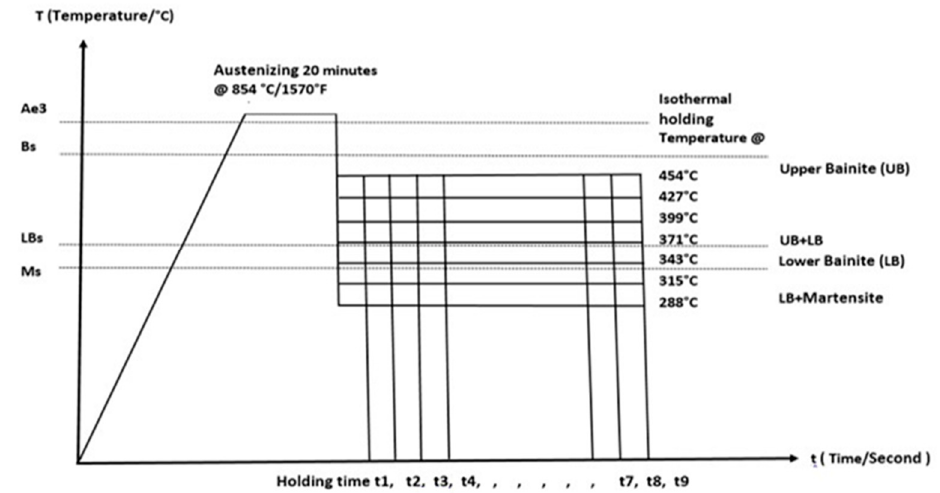
Figure 1. 4140 steel and austempering heat treatment schedules.